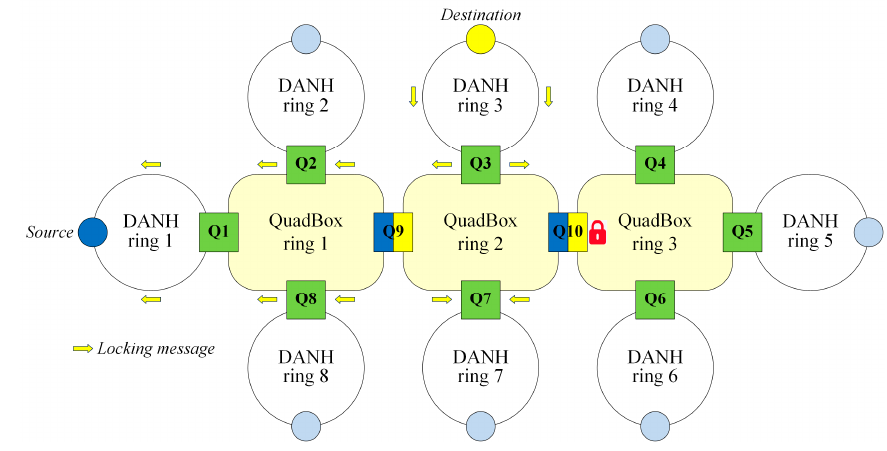
Figure 10. The process of the locking step.